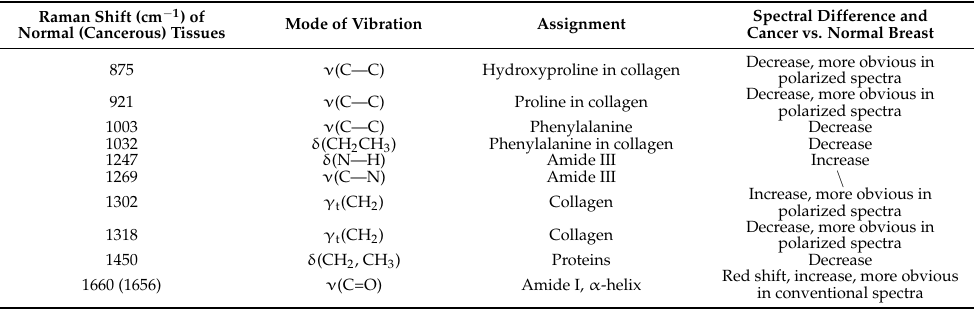
Spectral Difference and Cancer vs. Normal Breast